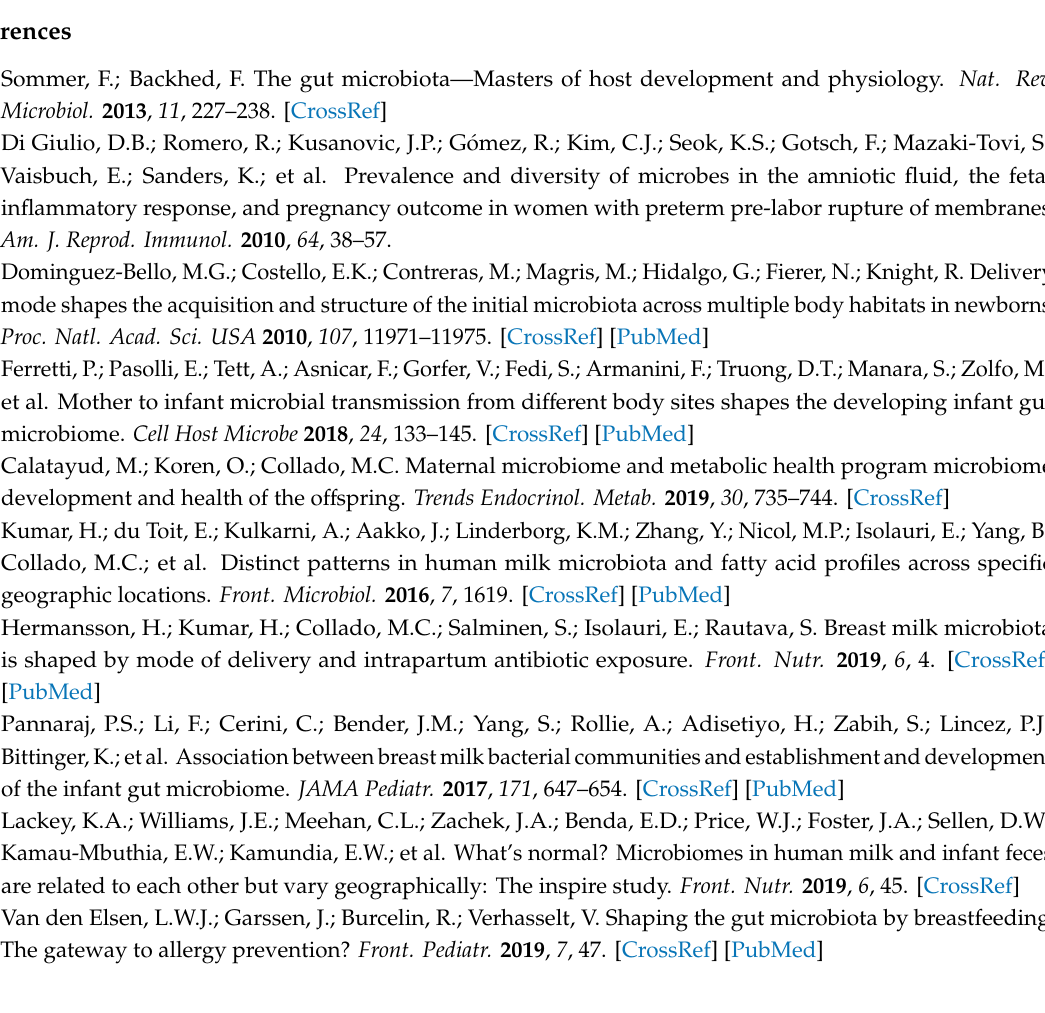
Table S10: Relative abundance of bacteria in the infant’s feces at the genus level categorized according to the mode of delivery; Table S11: Summary of immune modulatory proteins analyzed, their potential impact on infant health, and maternal diet and lifestyle influences a ff ecting their concentrations in breast milk; Figure S1: Immune-related proteins in the mother’s breast milk categorized according to the mode of delivery of